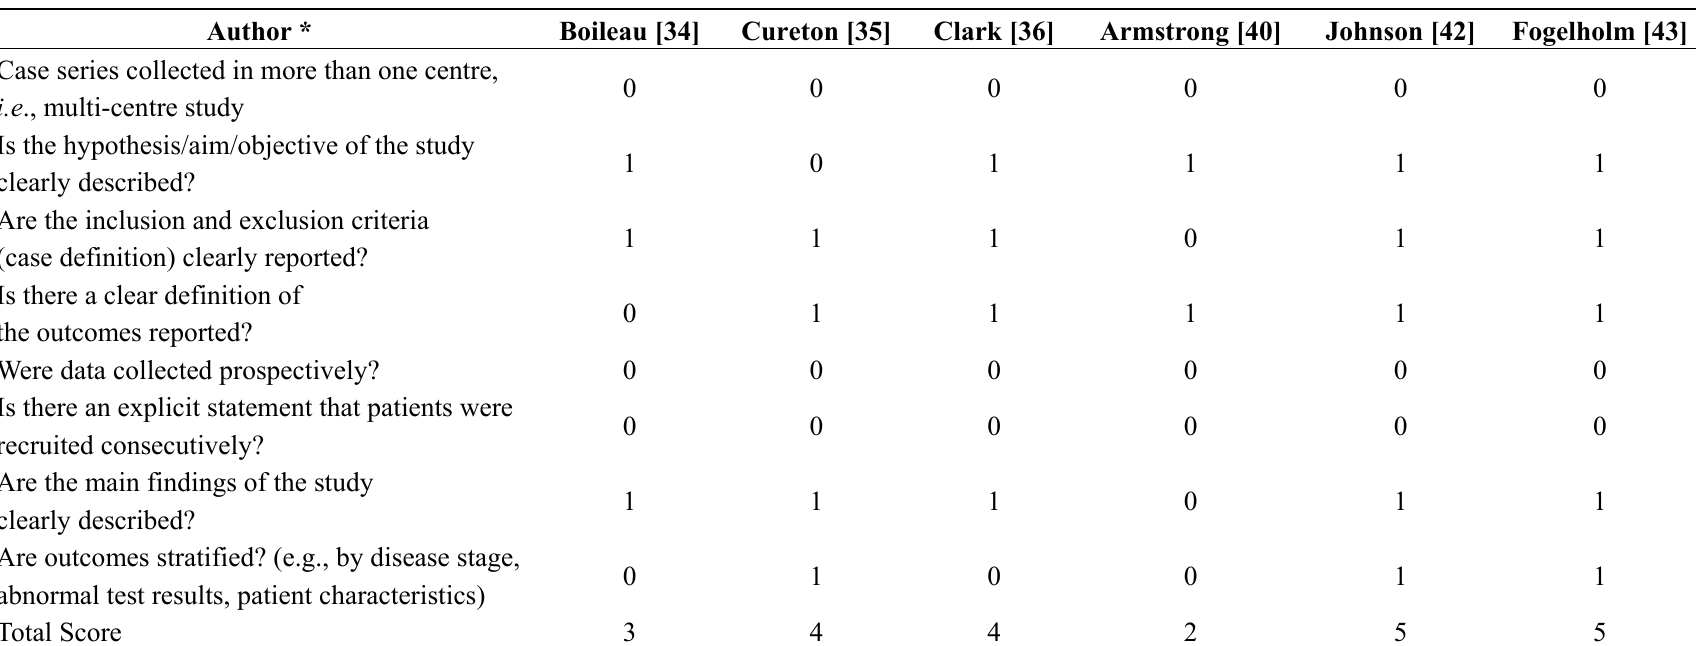
Table 4. Evaluation of methodological qualities of studies assessing the effect of eating disorders features on sport